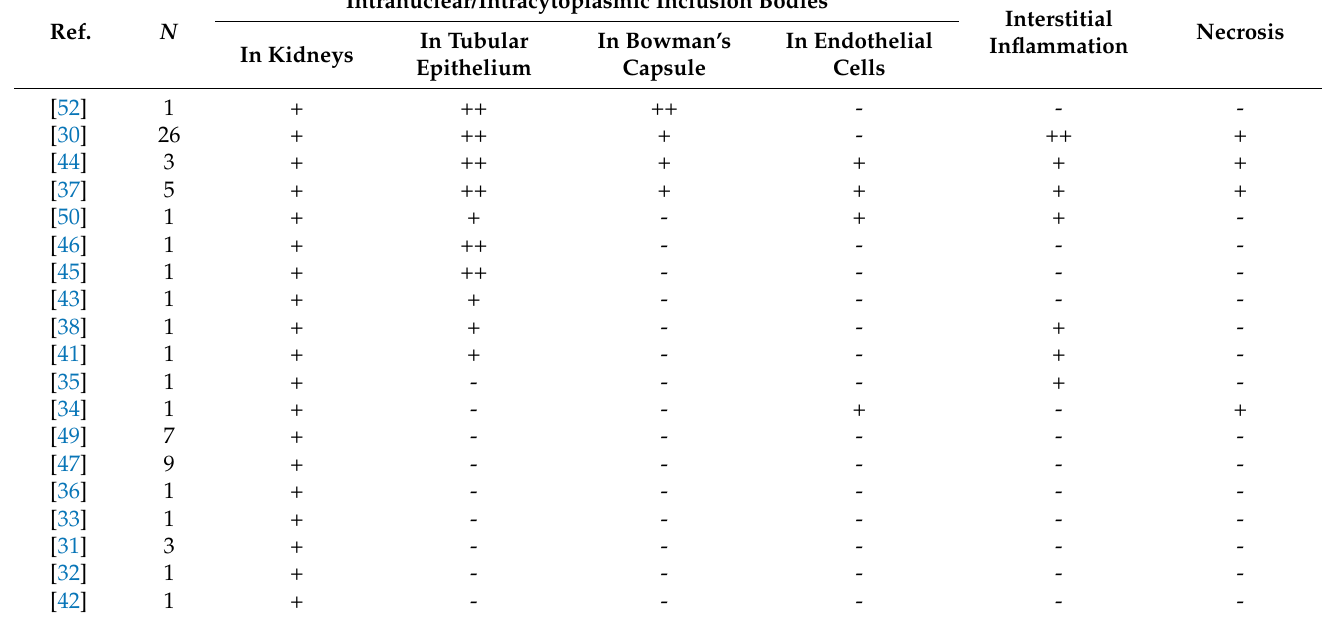
Table 3. Details of the most common histopathological findings in renal tissue ((++) main finding, (+) reported, and (-) not reported/unknown). Intranuclear/intracytoplasmic inclusion bodies were reported in all cases, but details on the cells that were affected were not always provided. Chen et al. [51] did not report typical CMV pathological findings.